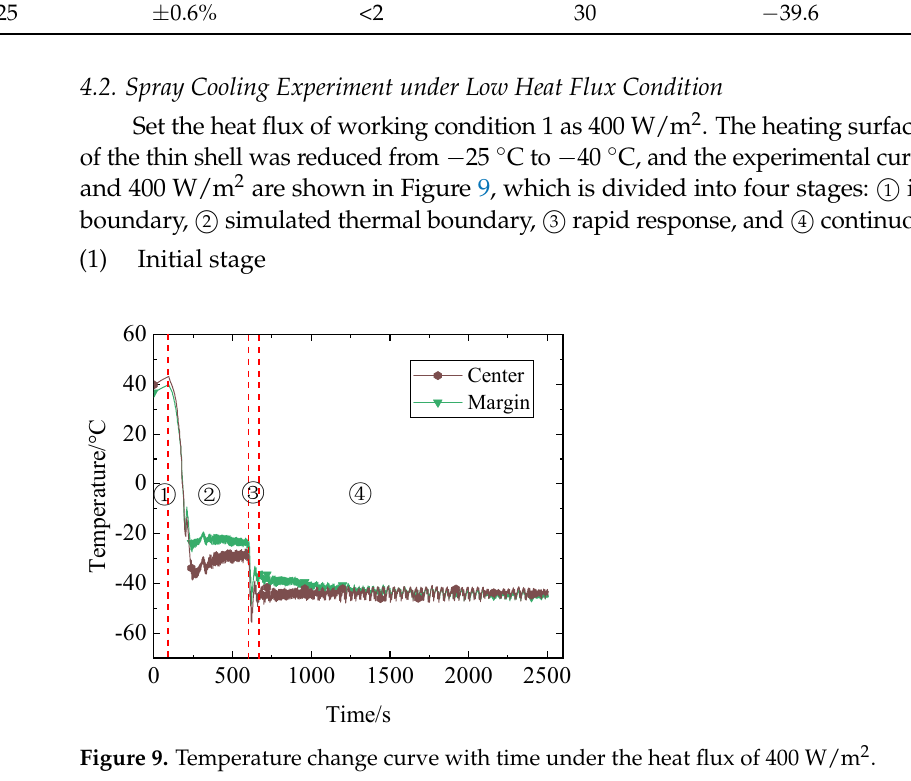
Figure 9. Temperature change curve with time under the heat flux of 400 W/m 2